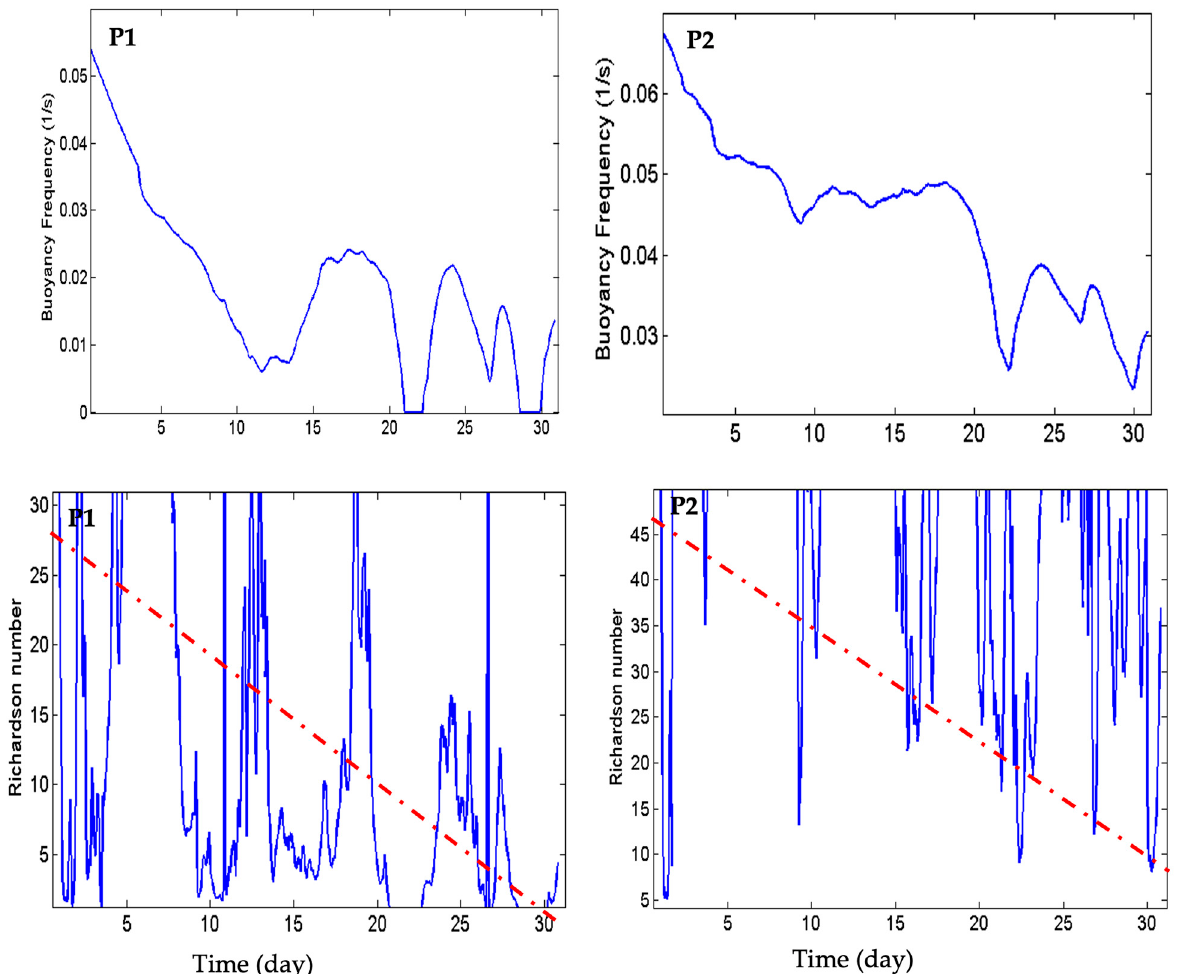
Figure 13. Variations of buoyancy frequency and the Richardson number across the water column during one-month simulation during October 2009 for: ( left panels) station P1 and ( right panel) station P2. The red dash line shows the trend of the Richardson number variations during the simulation.